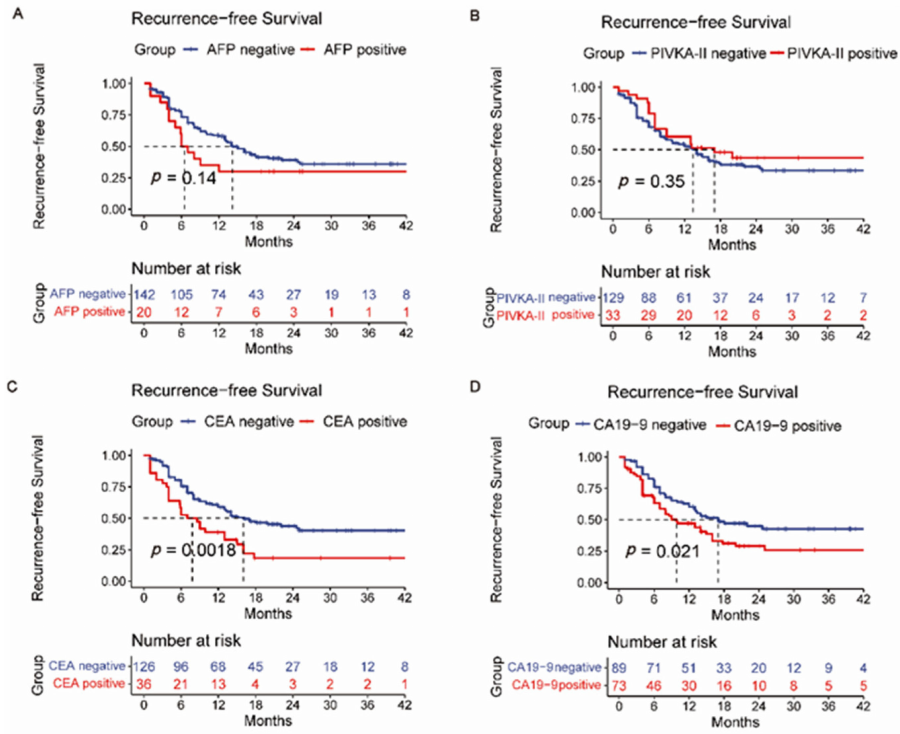
Figure 2. Recurrence-free survival (RFS) curves of grouped intrahepatic cholangiocarcinoma patients